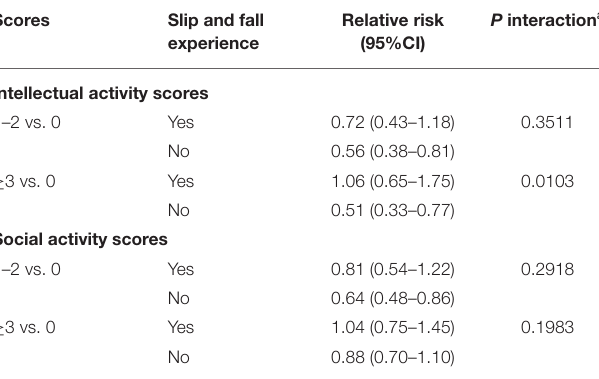
TABLE 3 | Subgroup analyses of the intellectual activity and social activity scores and the risk of frailty. P interaction a Scores Slip and fall Relative risk experience (95%CI) Intellectual activity